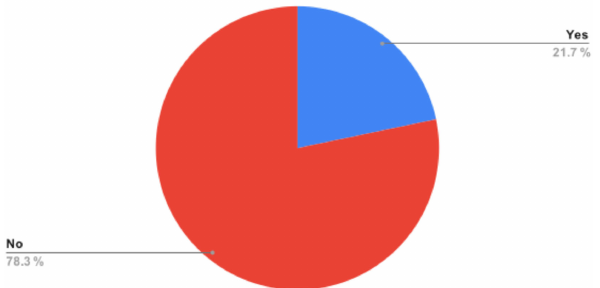
Figure 3. Perception of the pupils of the contents included in the curriculum on the topics of climate change and atmospheric pollu-